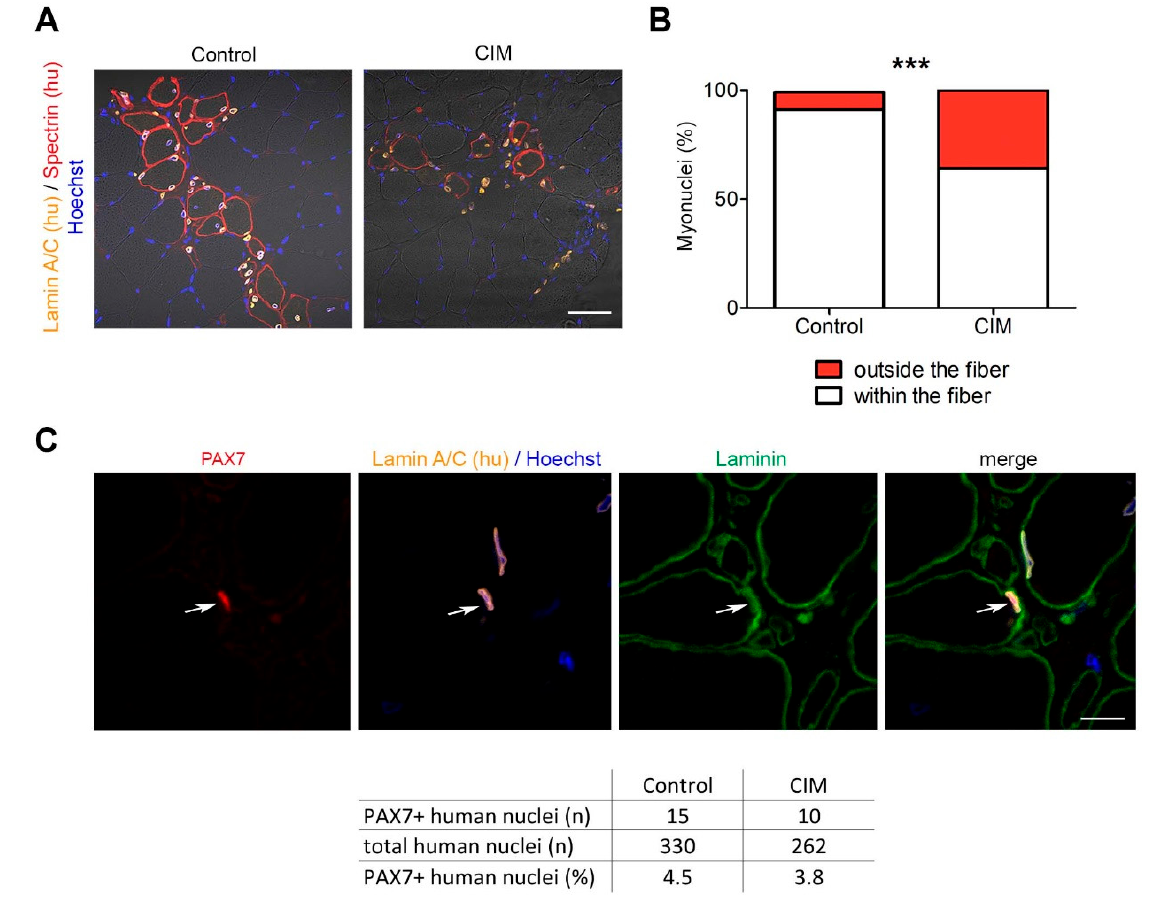
Figure 4. Reduced regenerative capacity of CIM-MuSC in vivo. ( A ) CIM-MuSC (1 × 10 5 ) was transplanted into the TA muscle of NOD mice. Immunofluorescent staining three weeks after transplantation: human Lamin A/C (yellow), human spectrin (red), Hoechst (blue) (CIM, n = 3 mice; control, n = 4 mice). Scale bar 50 µ m. ( B ) Quantification of human nuclei integrated into muscle fibers (white) and cells that failed to integrate into muscle fibers (red). Chi-square test; *** p < 0.0001; >300 nuclei were counted per condition. ( C ) PAX7 positive human myonuclei located in their anatomical niche (red: PAX7, blue: Hoechst, green: Laminin, orange: human Lamin A/C). Arrow shows the same nuclei. Scale bar 10 µ m. Quantification of PAX7-positive cells within the stem cell niche.